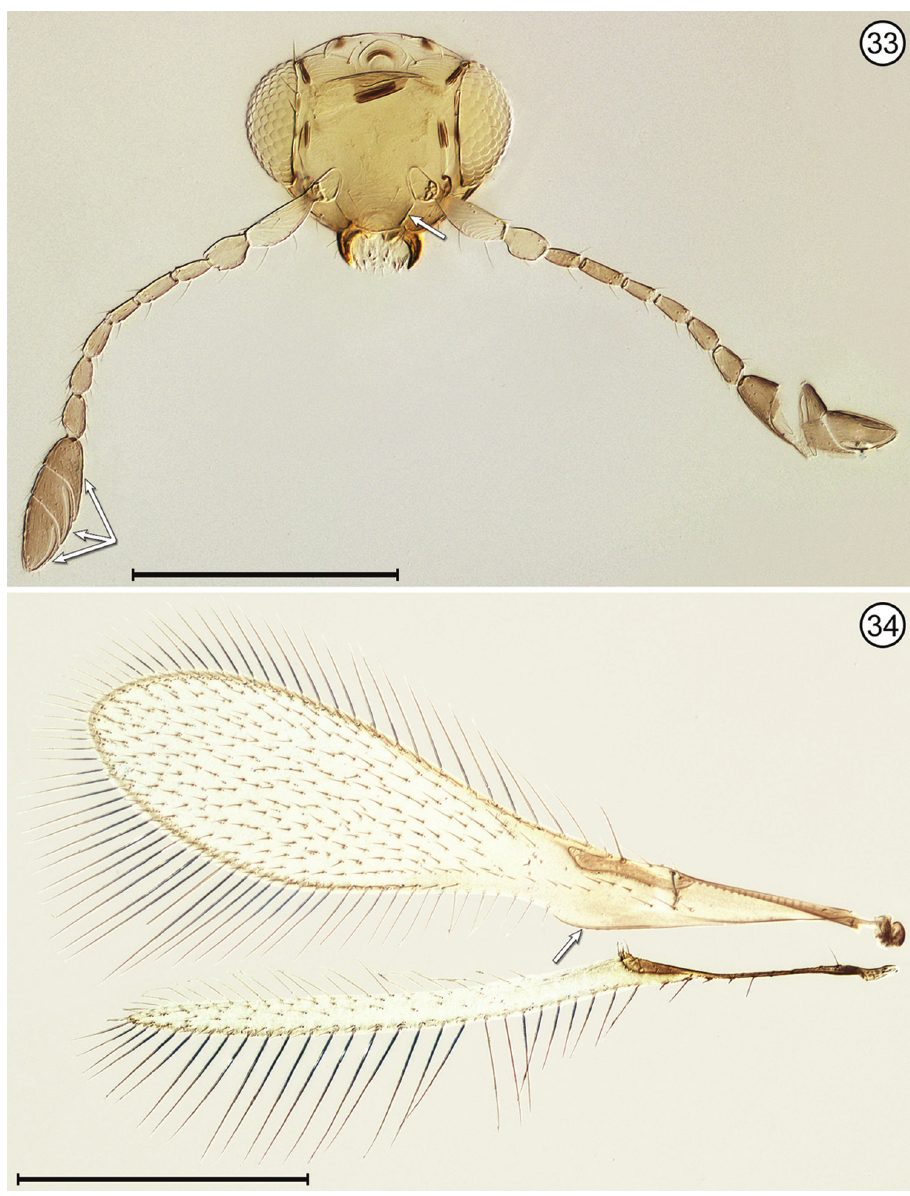
Figures 33, 34. Stethynium sp., female 33 head, anterior + antennae 34 wings. Scale bars = 200